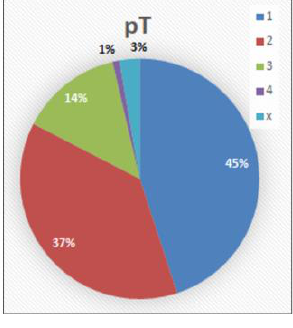
Figure 4. WHO grade distribution.